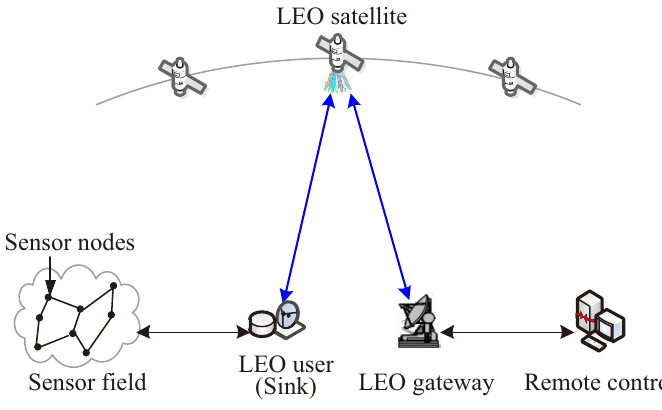
Figure 1. Architecture of the integrated wireless multimedia sensor and cognitive satellite